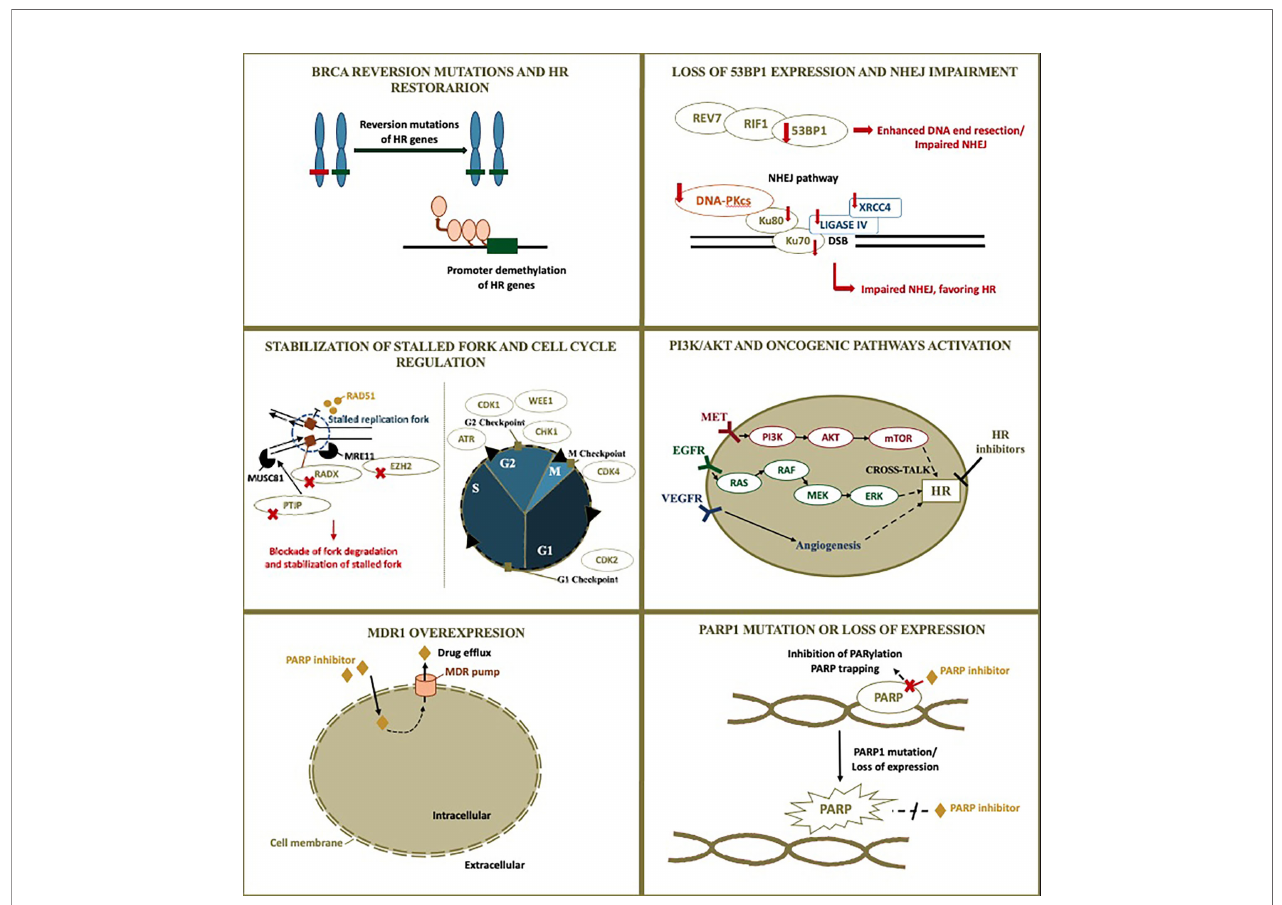
FIGURE 1 | PARP inhibitor resistant mechanism and rationale for combinations. Although homologous recombination restoration due to secondary somatic reverse mutations is well-described as a possible resistance mechanism to PARP inhibitors, many other alterations are also possibly implied. The fi gure illustrates PARP inhibitor resistant mechanisms and the rationale for combinations currently under investigation in ovarian cancer. Additional blockade of DNA repair may be achieved through targeting other proteins involved in DNA repair, modifying cross-talking pathways to result in a contextual homologous recombination de fi ciency, and impairing the cell cycle. The following resistant mechanisms are represented: 1) BRCA reversion mutations and homologous recombination restoration; 2) Loss of 53BP1 expression and non-homologous end-joining impairment; 3) Stabilization of stalled fork and cell cycle regulation; 4) PI3K/AKT and other pathogenic pathways activation; 5) MDR1 overexpression; 6) PARP1 mutation or loss of expression. HR, homologous recombination; NHEJ, non-homologous end-joining; PARP, poly (ADP-ribose) polymerase; MDR1, multidrug resistance protein